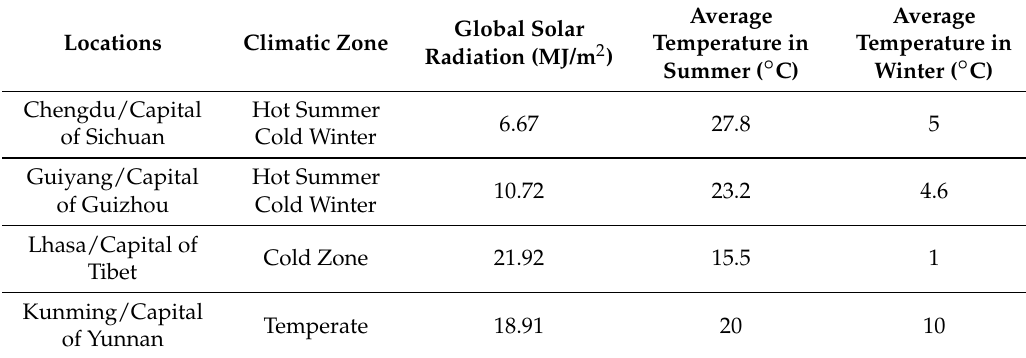
Table 4. Radiation and temperature of four